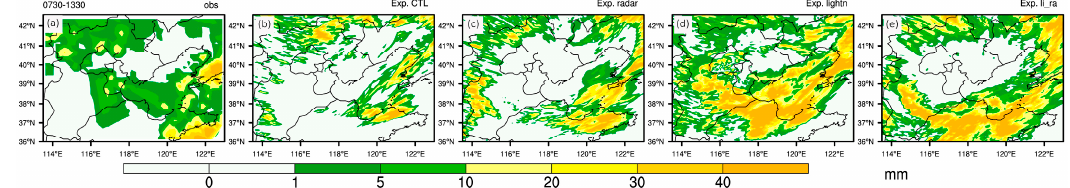
Figure 8. Forecast 6 h accumulated precipitation for: ( a ) observation; ( b ) Exp. CTL; ( c ) Exp. Radar; ( d ) Exp. Lightn; and ( e ) Exp. li_ra (unit: mm).